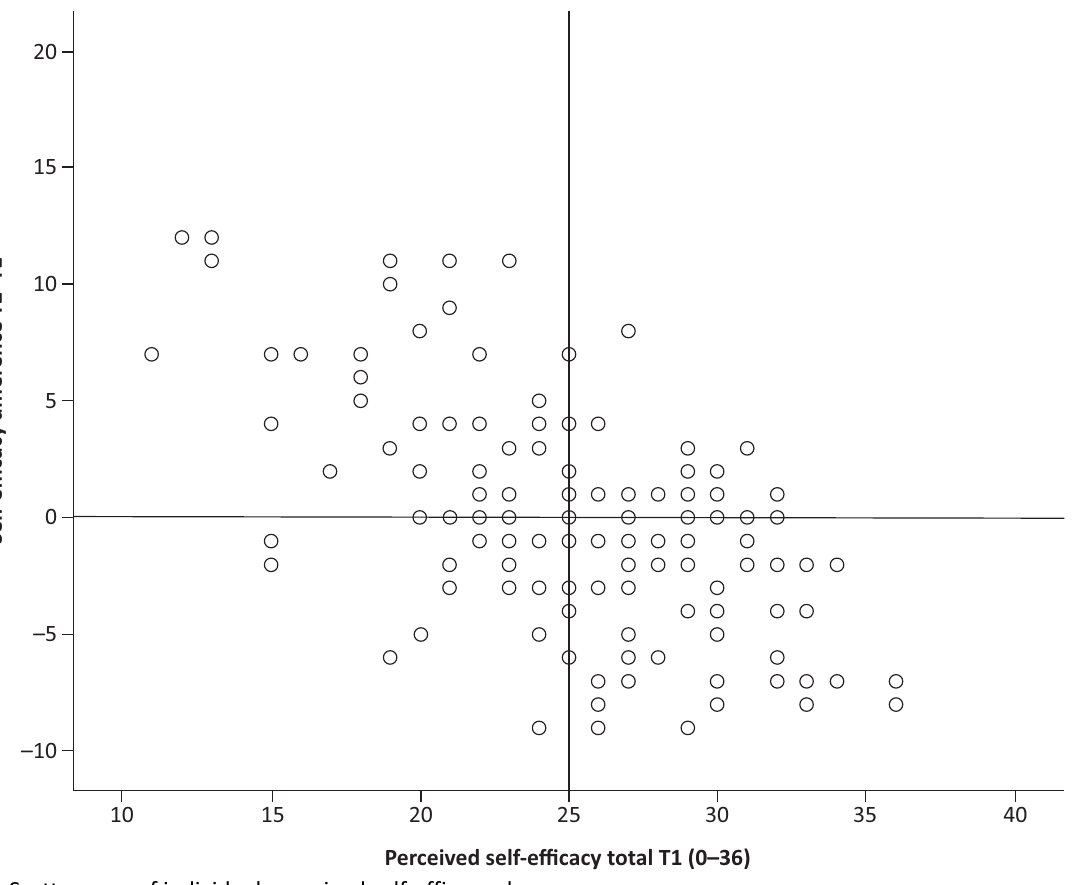
Figure 4. Scattergram of individual perceived self-efficacy